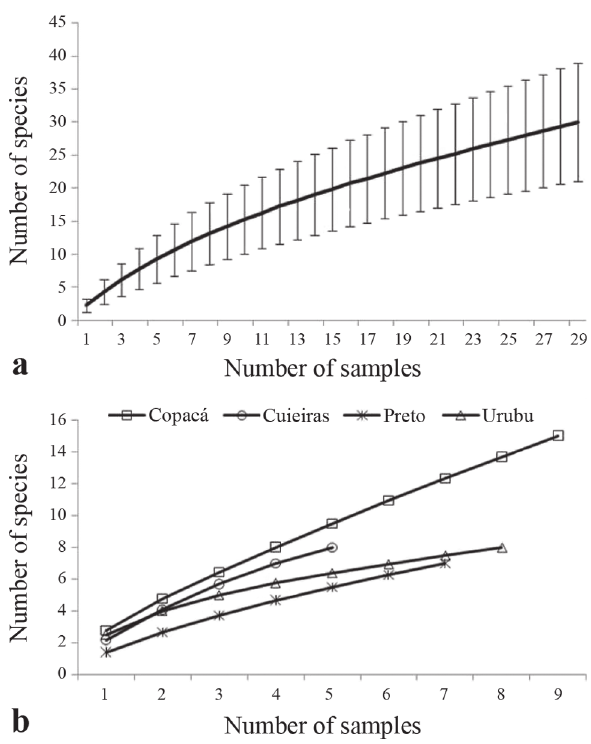
Fig. 2. Rarefaction curve (Mao Tau Index) based on the number of samples collected in floating litter banks in four river basins in the Brazilian Amazon (Copacá, Cuieiras, Preto da Eva, and Urubu rivers). ( a ) All floating litter banks recorded, and ( b ) disentangling rarefaction models for each river